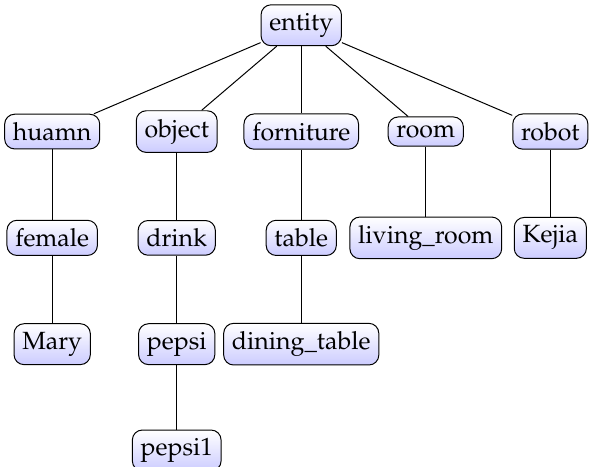
Figure 2. Illustrate the type hierarchy. There are five top types in our system: robot, human, furniture, room, and